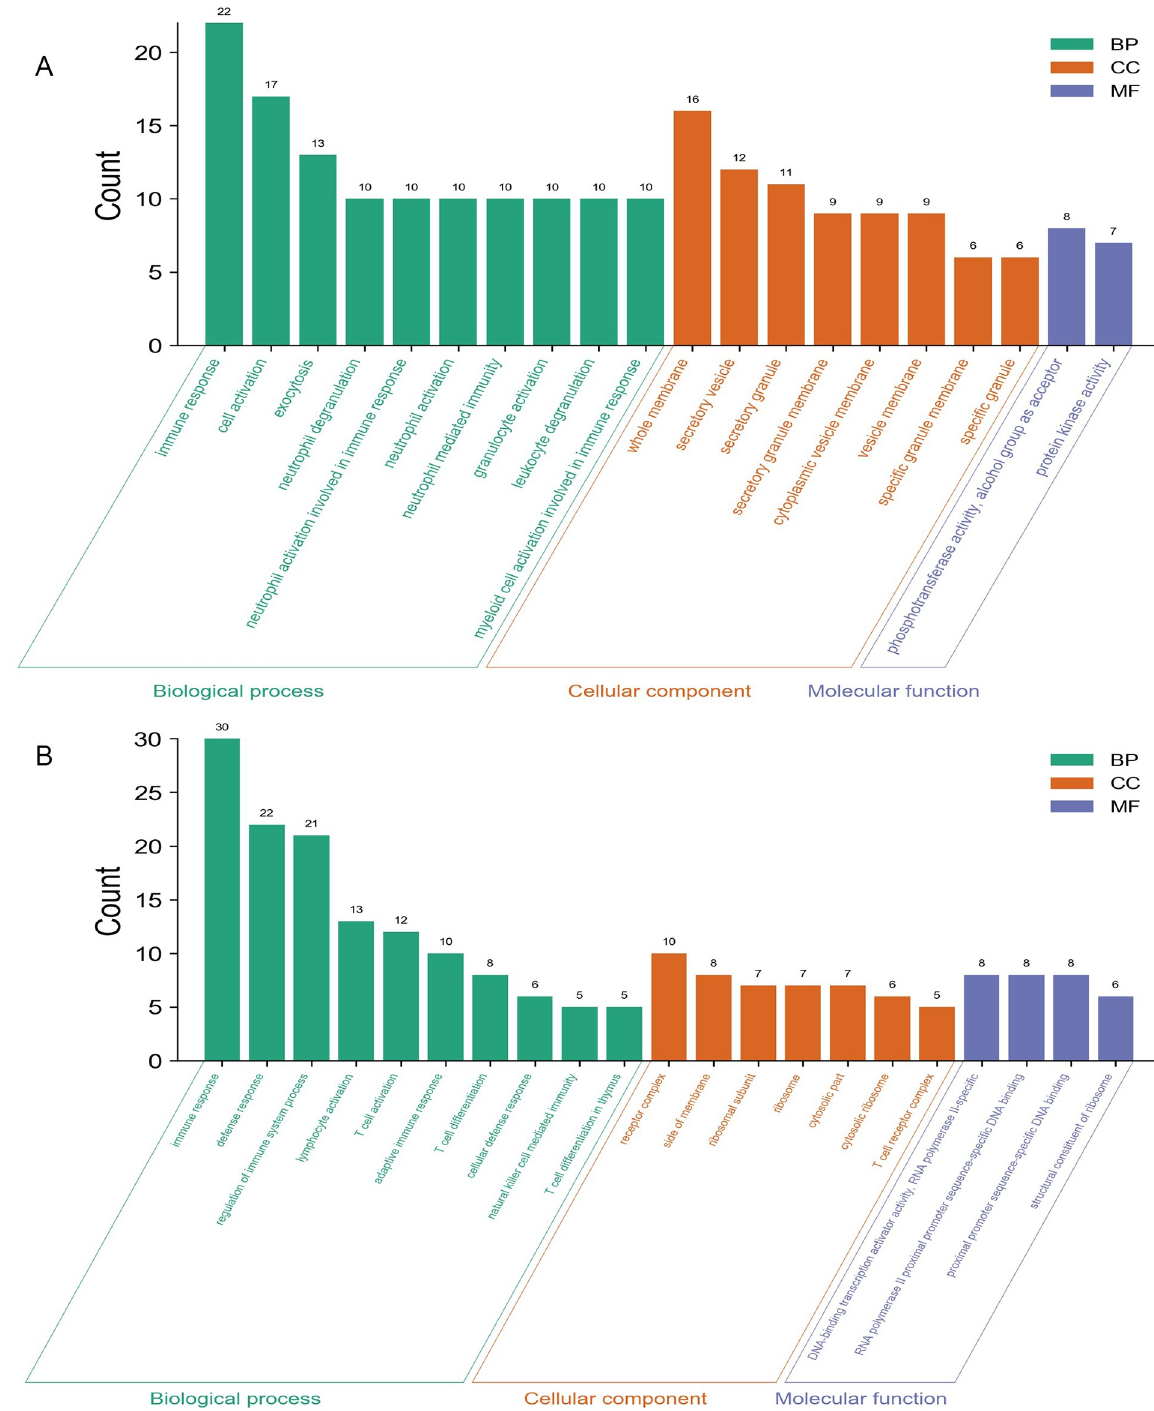
Fig 4. GO analyses of the overlapping upregulated (A) and downregulated (B) DEGs. The y-axis depicts the number of genes. The x-axis lists the enriched functional terms. The color of bars corresponds to different categories of GO analysis (green represents BP, orange represents CC, and purple represents